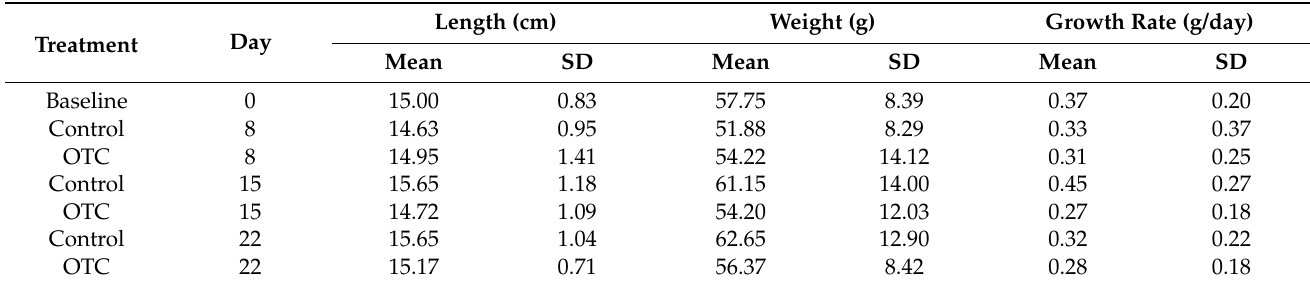
Table 1. Final mean (+SD) length and weight measurements for control or oxytetracycline (OTC)-treated Nile tilapia before, during, and after antibiotic treatment.